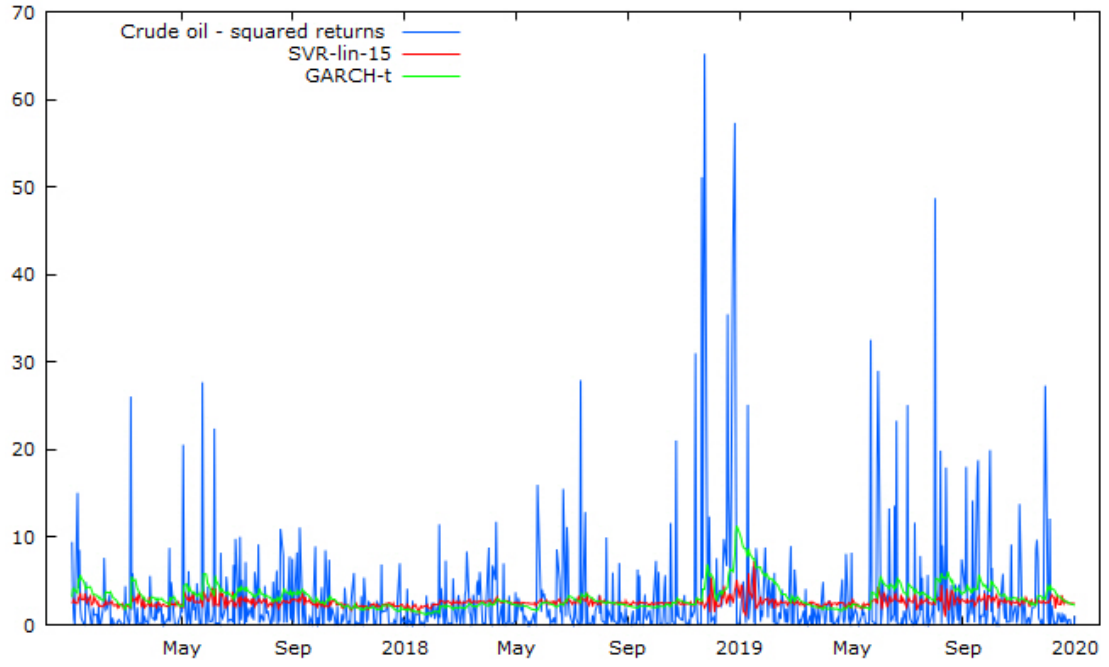
Figure 2. One-day-ahead volatility forecasts and the squared daily returns for crude